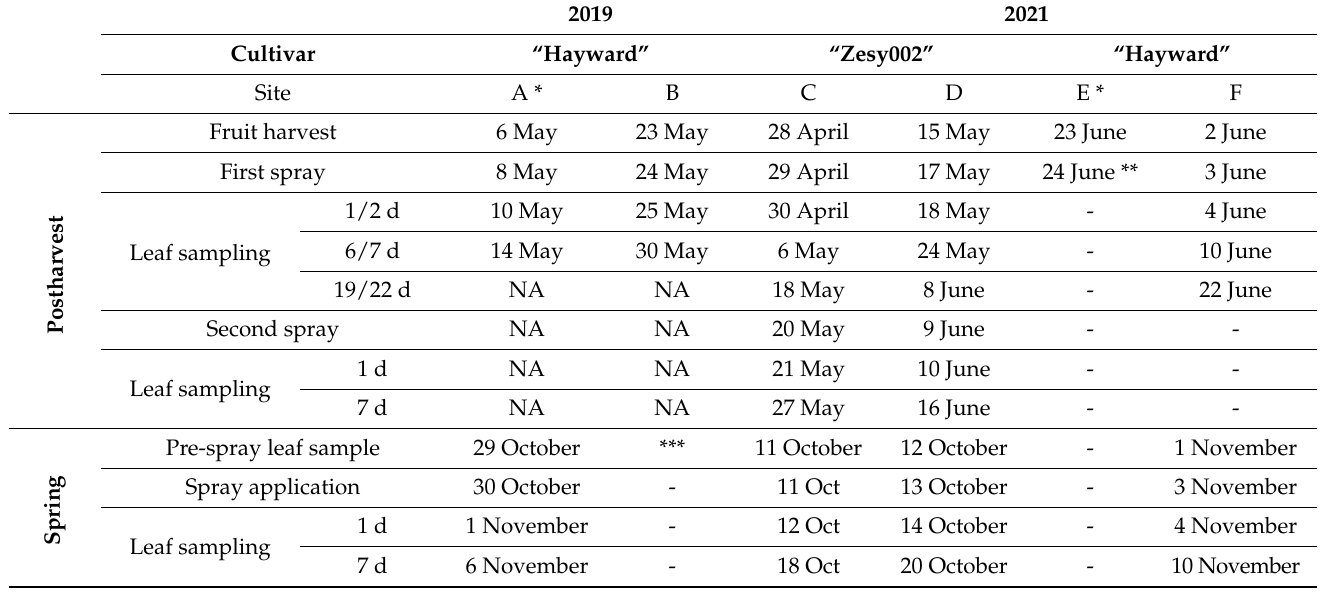
Table 4. Dates for fruit harvest, applications of Kocide ® Opti™ and Kocide ® Opti™ + Actigard ® and leaf sampling from Actinidia chinensis var. deliciosa “Hayward” and in A. chinensis var. chinensis “Zesy002” kiwifruit vines during 2019 and